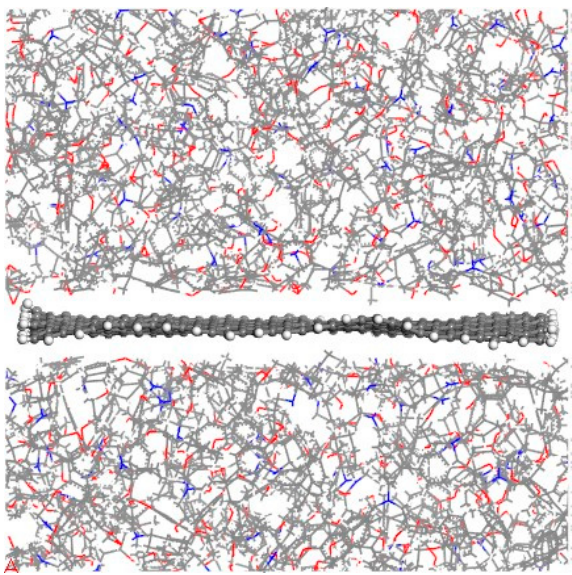
Figure 4. Interaction energies of graphene and a polymer matrix in composite models with different CNT radii during the pullout process.